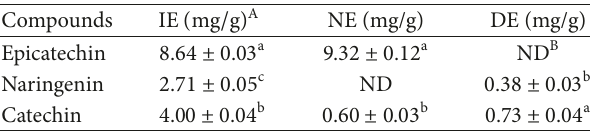
Table 2: Phenolic compound content (mg/g dried SCE). Compounds Epicatechin